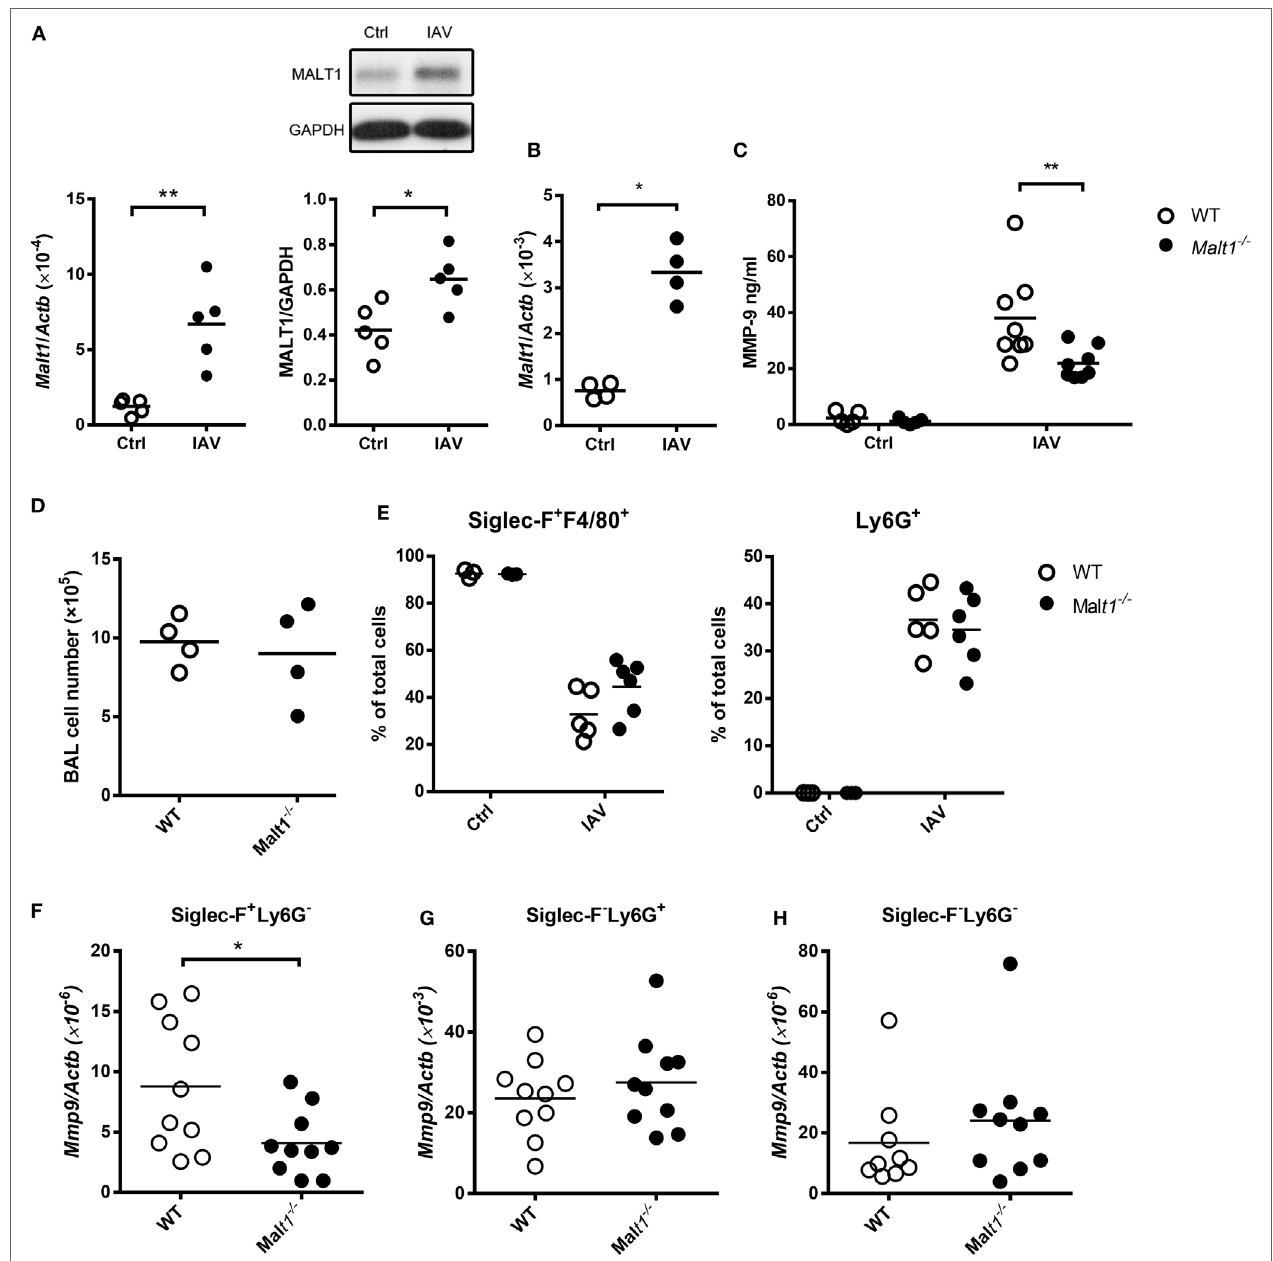
FigUre 6 | Influenza A virus infection induces mucosa-associated lymphoid tissue lymphoma translocation protein 1 (MALT1) upregulation that contributes to matrix metalloproteinase-9 (MMP-9) production in the lungs. (a) Wild-type mice were infected with of 5 × 10 4 PFU of WSN virus intratracheally. Lungs were harvested from uninfected and infected mice on day 2 after infection. Total RNA in lungs were extracted and applied to qPCR. The mRNA levels of Malt1 was normalized against Actb (left panel). Lysates were blotted with anti-MALT1 and anti-GAPDH antibodies (upper right panel) and the intensity of MALT1 was normalized against that of GAPDH (lower right panel). One representative experiment is shown. (B–h) Malt1 − / − and/or wild-type mice were infected with 5 × 10 3 PFU of WSN virus intratracheally. (B,D) On day 4 after infection, bronchoalveolar lavage (BAL) cells were (B) subject to RNA extraction for the determination of the levels of Malt1 transcripts by qPCR and (D) counted for the number of cells. (c,e–h) BAL was collected on day 2 after infection. (c) The concentration of MMP-9 in BAL was quantified by ELISA. (e) Cells in BAL were stained with anti-Siglec-F, anti-F4/80, and anti-Ly6G antibodies. Cells were analyzed by flow cytometry. (F–h) Cells in BAL were sorted by their expressions of Siglec-F and Ly6G surface markers. Total RNA of sorted cells were extracted and Mmp9 mRNA were quantified by qPCR and normalized against Actb . Each dot represents cells from one mouse. Data are a compilation of two (a,B,D) and three (c,e–h) independent experiments. * p < 0.05 and ** p < 0.01 compared to control. Data in (a,B,D,F–h) were analyzed by Mann–Whitney U -test. Data in (c,e) were analyzed by one-way ANOVA followed by Sidak’s post hoc